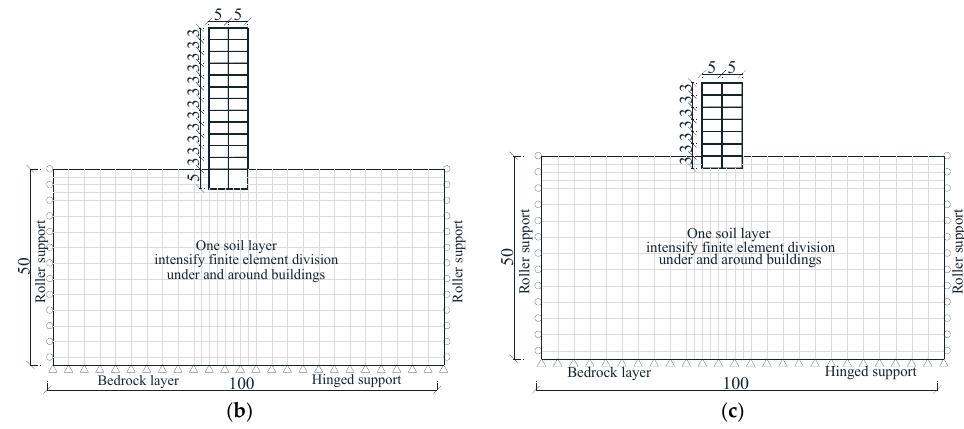
Figure 3. The buildings with soil mesh of modelled representation. ( a ) The two adjacent buildings with unequal foundation levels; ( b ) Single 12-floor building (with foundation at − 5 m); ( c ) Single 6-floor building (with foundation at − 3 m). Table 1. Soil Properties.